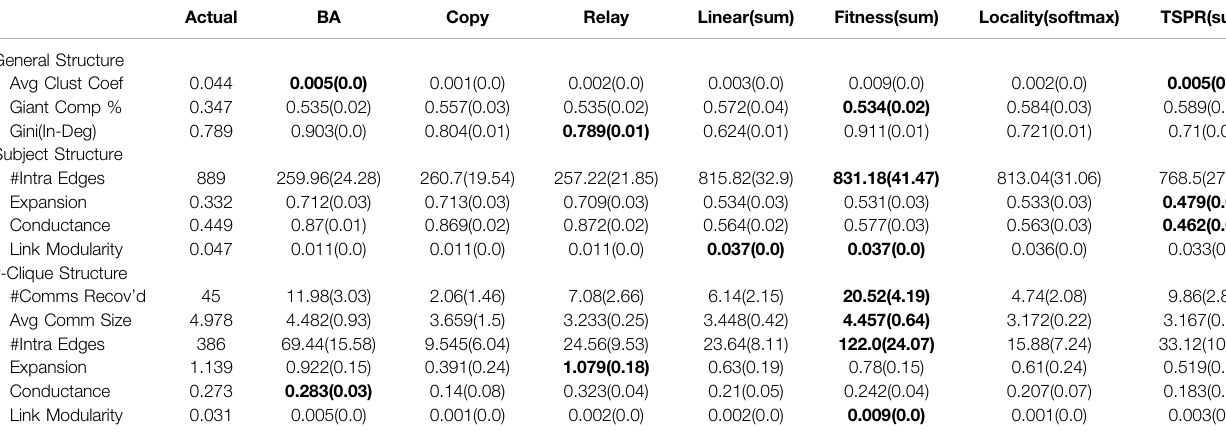
TABLE 4 | Actual versus simulated properties for the SGCA